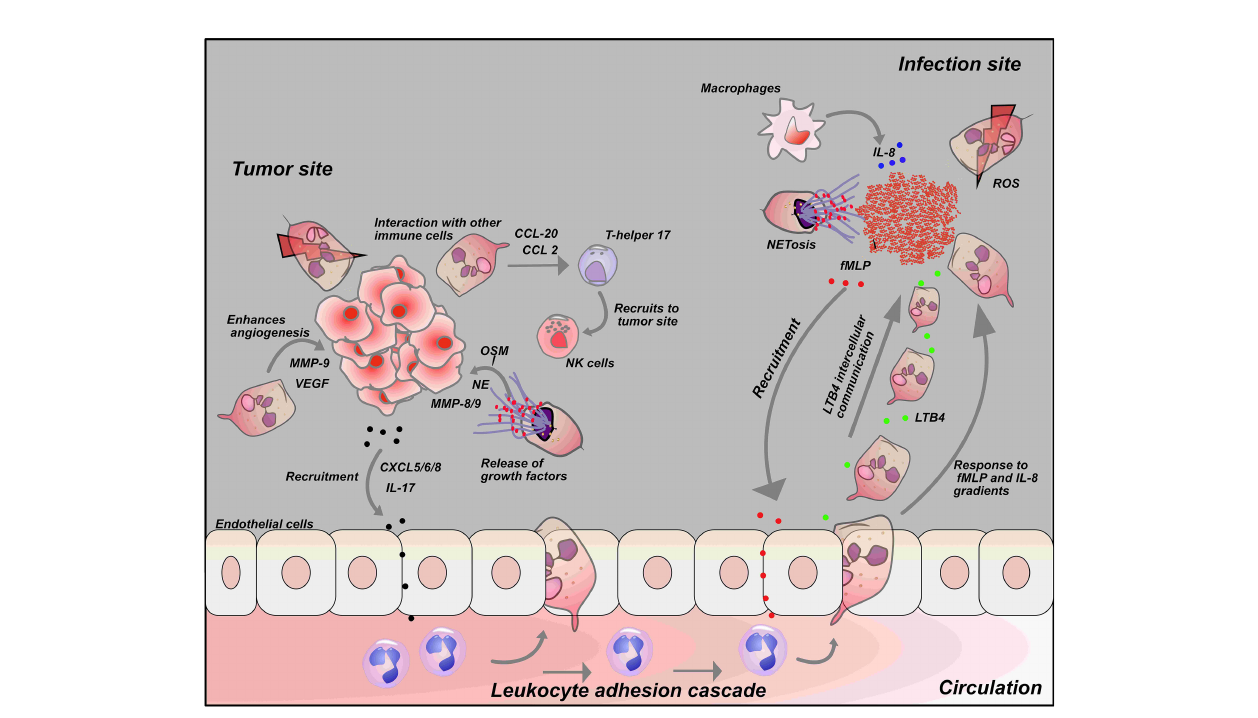
FIGURE 3 | Neutrophil interaction with tumor cells and other immune cells: Interactions with tumor cells and other immune cells in fl uences the neutrophil response. Tumor cells release chemokines such as CXCL-5, CXCL-6, CXCL-8 and IL-17 to recruit neutrophils to tumor cells. Secretion of chemokines such as CCL-20 and CCL-2 by neutrophils at tumor site activate T-helper 17 that in turn recruits anti-tumor immune cells like NK- cells to tumor cells. On the other hand, neutrophils can also release growth factors like NE, MMP-8/9 and VEGF at tumor sites that drives tumor metastasis and growth (Top left). At the infection site, fMLP, a known chemoattractant released by bacteria recruit neutrophils to the infection site. Neutrophils produce a secondary chemoattractant known as LTB 4 that drives intercellular communication among neutrophils and recruit more neutrophil to the infection site in a process described as swarming. Macrophages also induce neutrophil migration by releasing a potent chemoattractant, IL-8 at the infection site (Top